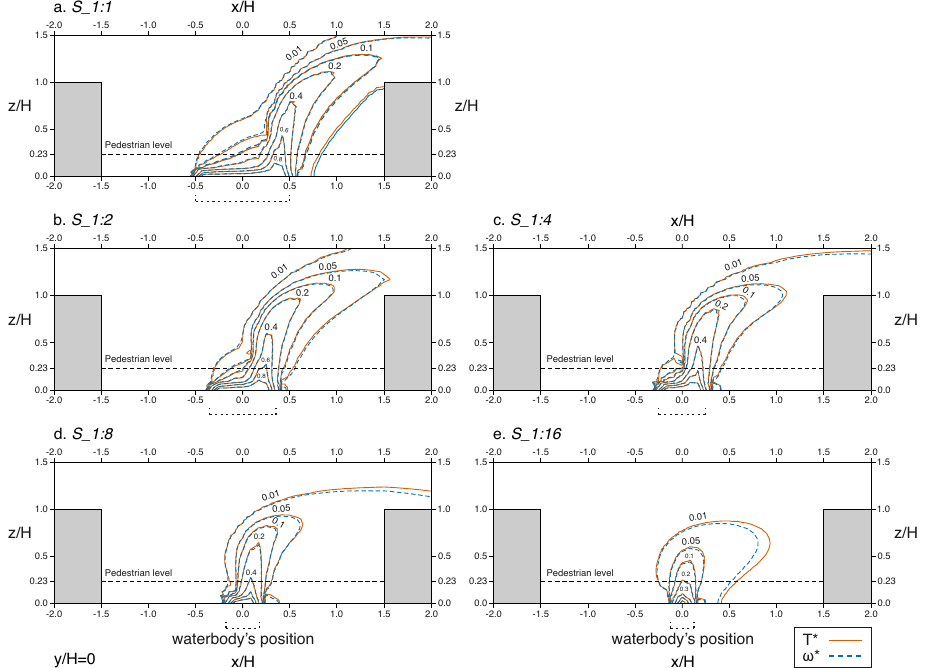
Figure 10. Contours of normalised temperature ( T ∗ ) and water vapour concentration ( ω ∗ ) over a vertical plane in the middle of the domain ( y / H = 0) for the warm water body cases ( ∆ T = + 2 K) and different water body sizes: ( a ) original size ( S_1:1 ). ( b ) half the original size ( S_1:2 ). ( c ) a quarter of the original size ( S_1:4 ); ( d ) one-eighth of the original size ( S_1:8 ); ( e ) one-sixteenth of the original size ( S_1:16 ).